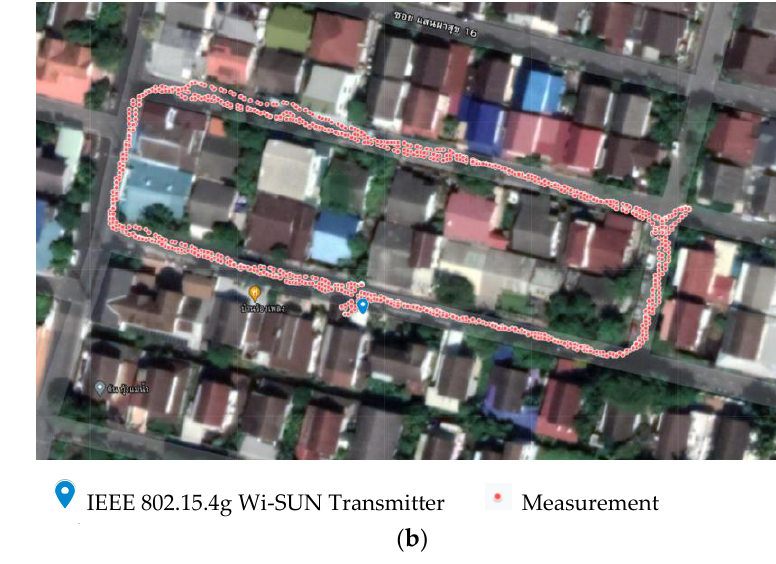
Figure 5. ( a ) IEEE 802.15.4g receiver on backpack, ( b ) the measurement points at the residential area. Table 3. System specification in the